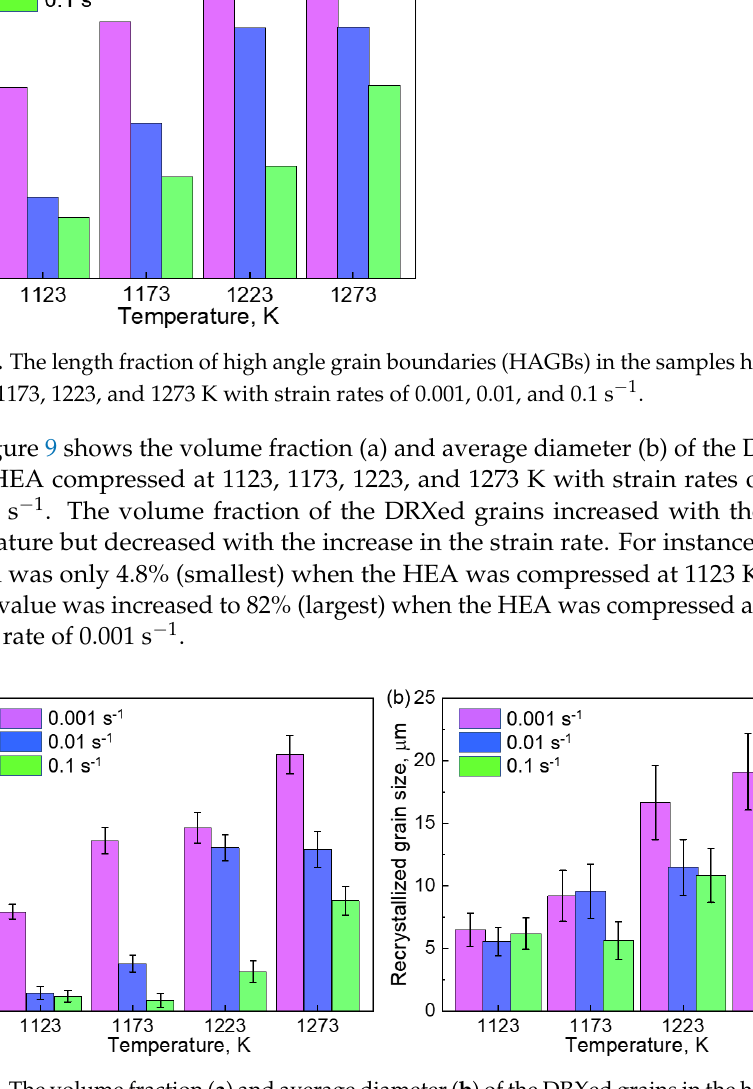
Figure 7. EBSD IQ maps of the Co 35 Cr 25 Mn 15 Ni 15 Fe 10 TRIP-HEA hot-compressed at ( a , e , i ) 1123 K, ( b , f , j ) 1173 K, ( c , g , k ) 1223 K, and ( d , h , l ) 1273 K with strain rates of ( a – d ) 0.001 s −1 , ( e – h ) 0.01 s −1 , and ( i – l ) 0.1 s −1 , respectively.